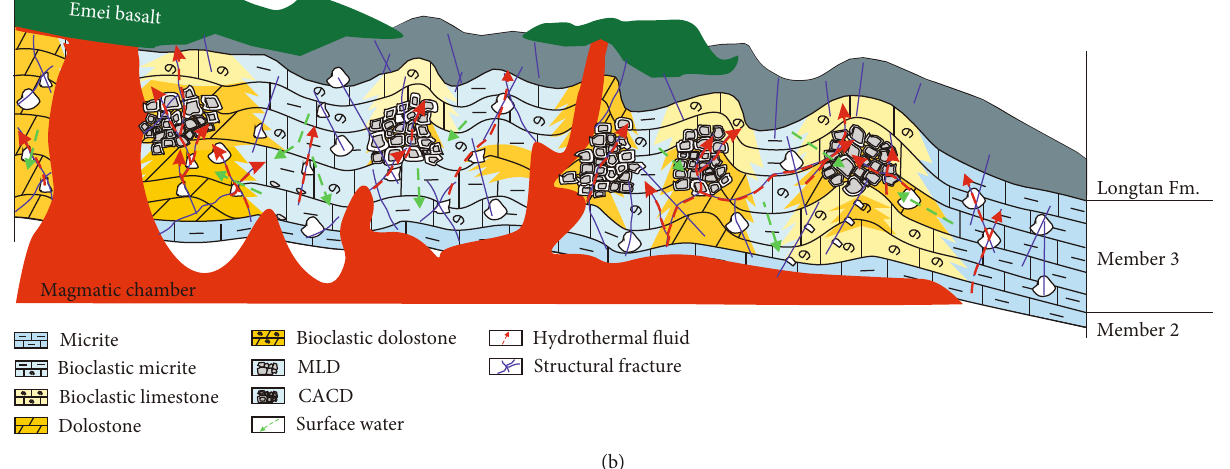
Figure 11: Dolomitizing model of the Middle Permian Maokou Formation in Eastern Sichuan. MLD: mosaic-like dolomite. CACD: clear- rimmed